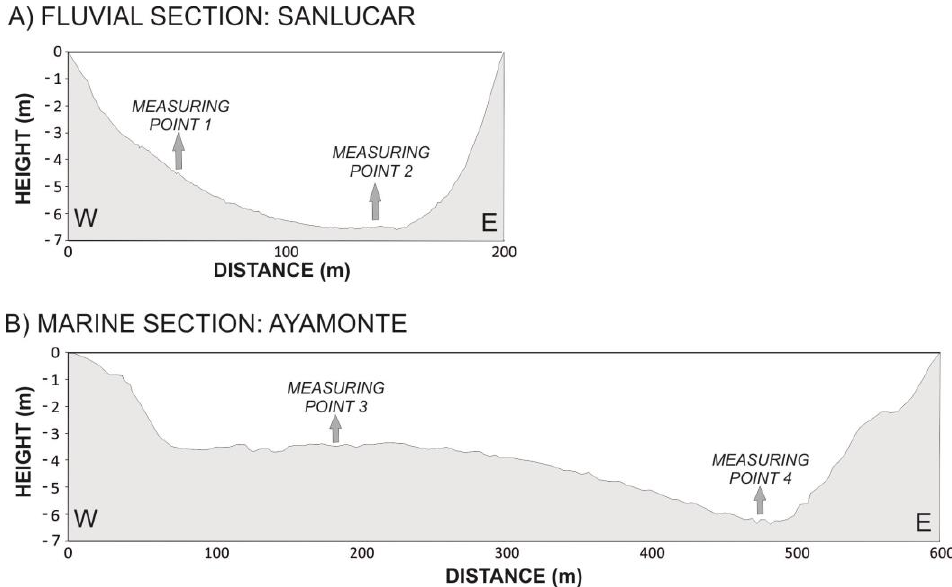
Figure 2. Flow sections where the measure points (acoustic Doppler current profiler (ADCP) and sediment traps) are indicated. ( A ) Inner (fluvial) section and ( B ) Outer (marine) section.